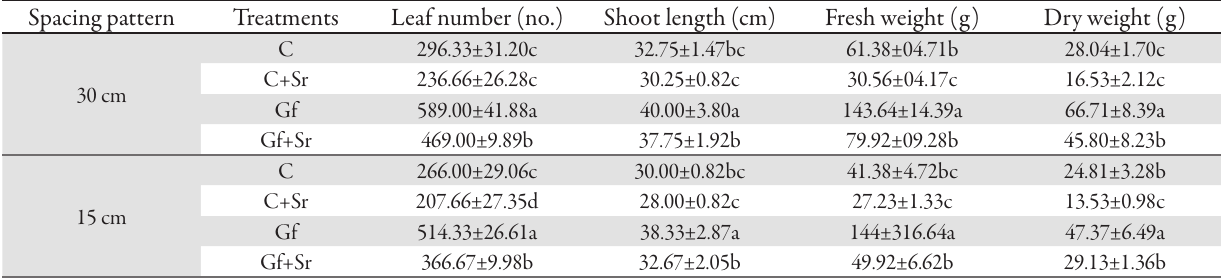
Tab. 4. Leaf number, shoot length, fresh and dry weight of A. hypogaea L. after 90 days after sowing and of AM inoculation and 75 days of S. rolfsii treatment in 30 and 15 cm plant spacing Spacing pattern